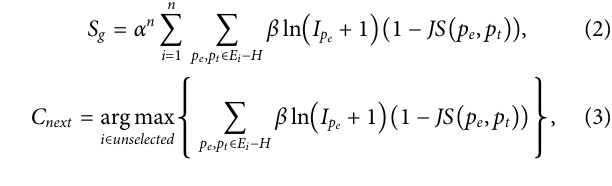
Frontiers in Chemistry |